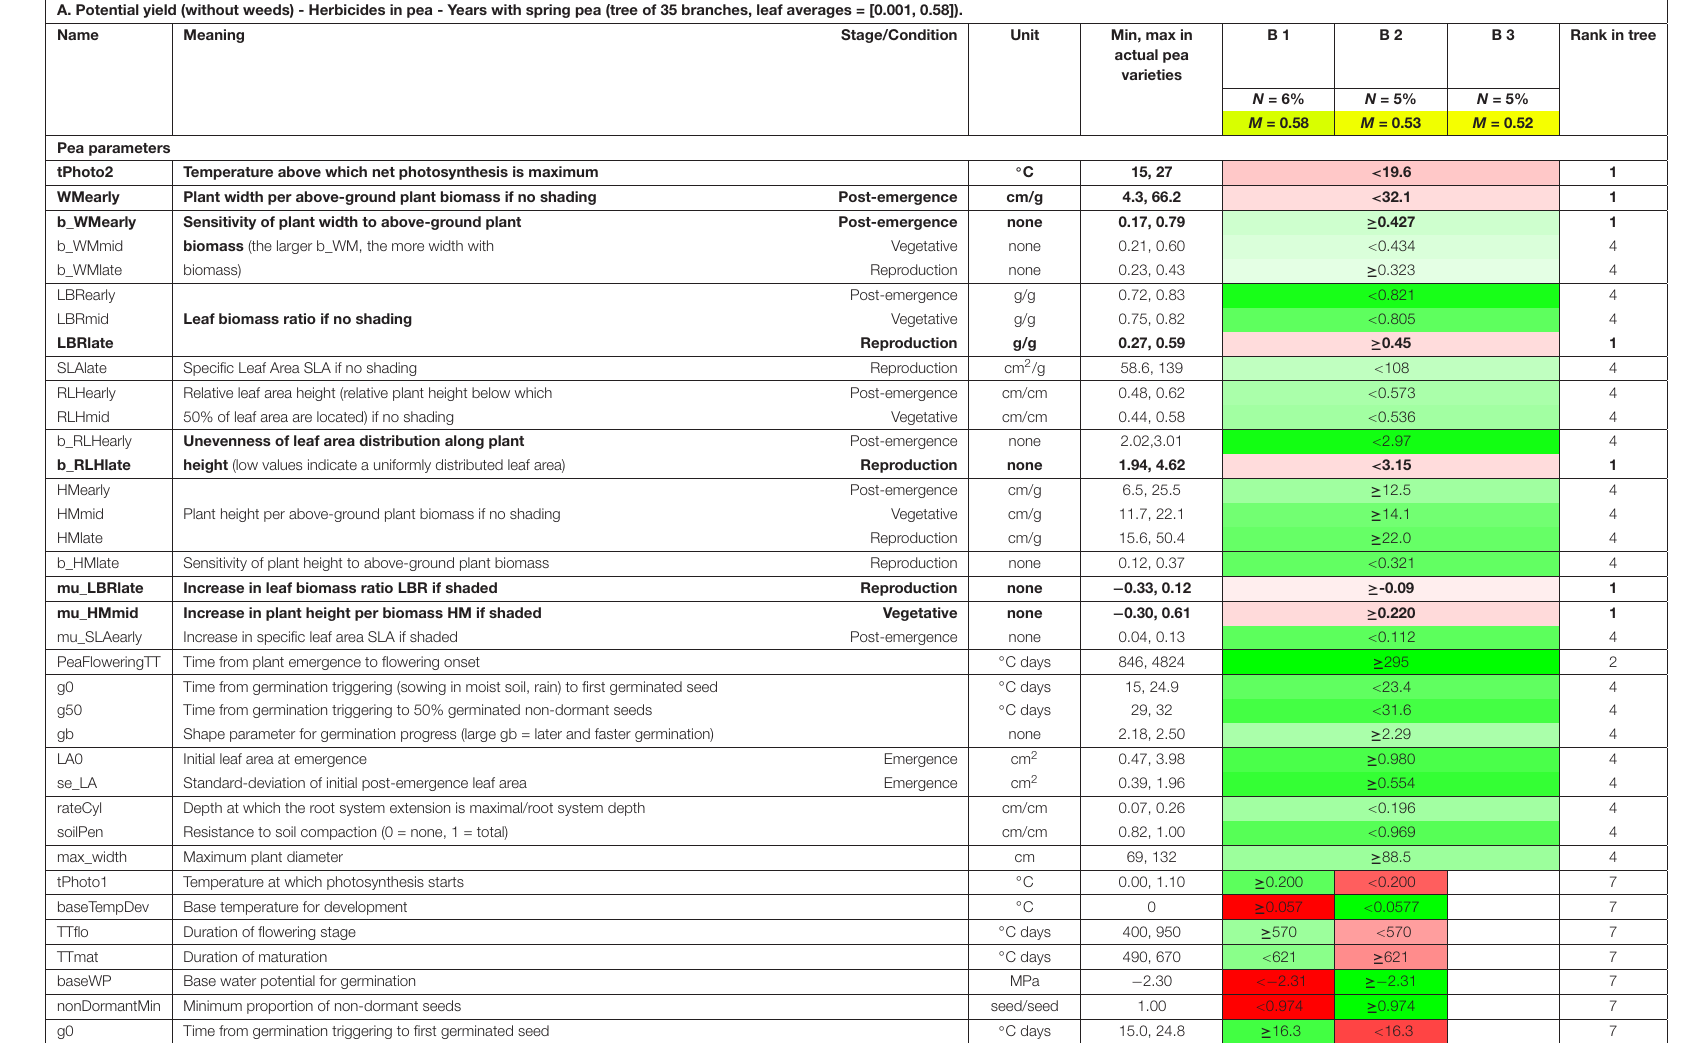
TABLE 5 | Optimal combinations of pea parameters, pea management, and other-crop management, depending on the goal, situation, analysis scale, and pea variety type (complete results in section E.8 of the Supplementary Material ). The three best scenarios (branches B1, B2, and B3) identified with classification and regression trees applied to 400 cropping systems × 12 years × 10 weather repetitions per situation. Indicator values were normed to [0, 1] with 0 the worst performance (i.e., lowest yield or highest yield loss) over all situations and 1 the best one (i.e., highest yield or lowest yield loss). In the case of multivariate response variables, branches were ordered by increasing values of the minimum of the response variables (see section “Statistics”). A and C: rules were colored from green (100% of the parameter range of variation of actual varieties consistent with the rule) to red (0% of the range covered) through white (50%). A. Potential yield (without weeds) - Herbicides in pea - Years with spring pea (tree of 35 branches, leaf averages = [0.001, 0.58]).